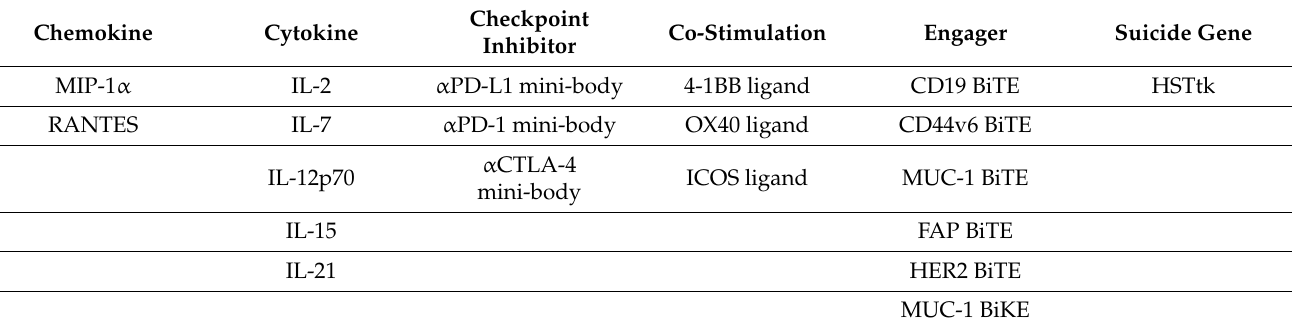
Table 1. Library of HDAds encoding immunomodulatory